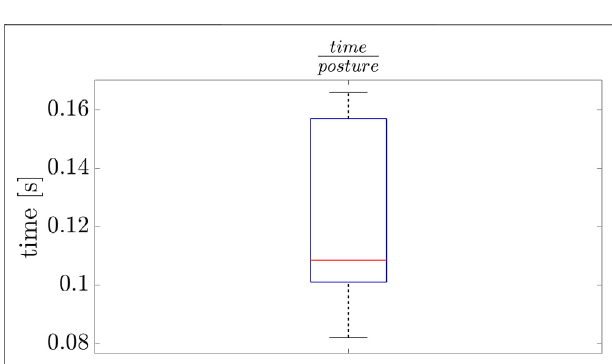
FIGURE 6 | Results from the scenario in Section 6.1